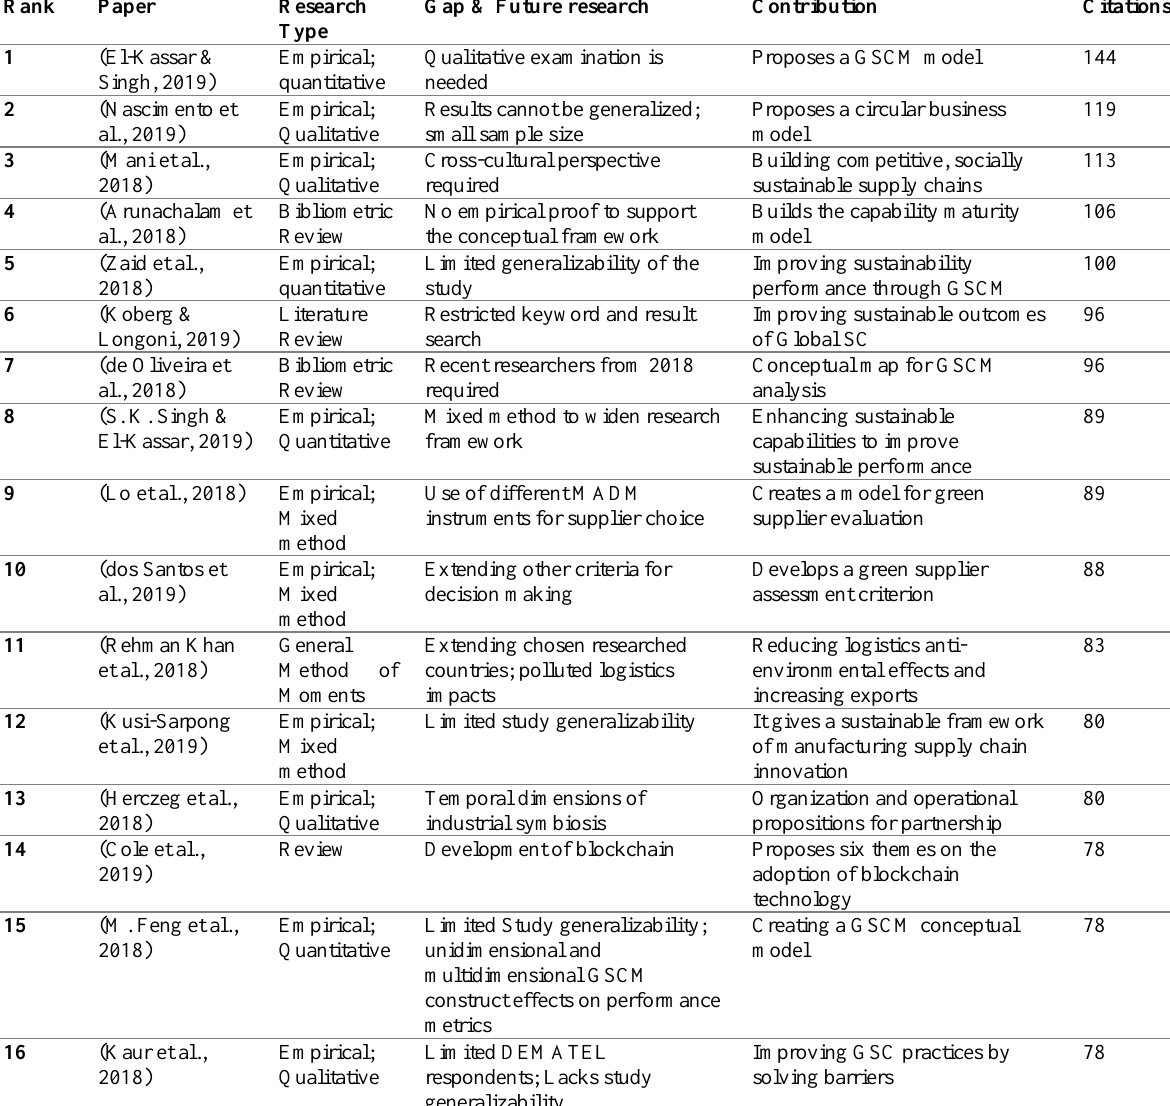
Table 6 : Top Documents Cited